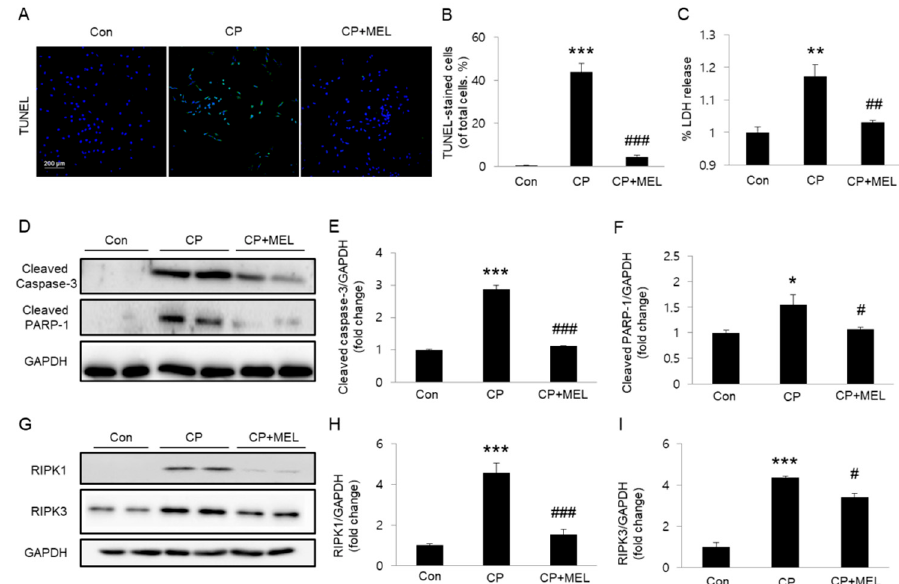
Figure 7. Effects of melatonin (MEL) on cisplatin (CP)-induced apoptosis and necroptosis in cultured TCMK-1 cells. TCMK-1 cells were pretreated with 1 mM MEL for 1 h and then treated with 2 μ g/mL CP for 24 h. ( A ) Representative images of TdT-mediated dUTP nick end labeling (TUNEL) staining. Scale bar: 200 μ m. ( B ) Number of TUNEL-positive cells. ( C ) lactate dehydrogenase (LDH) release assay. ( D ) Western blots of cleaved caspase-3 and cleaved poly(ADP-ribose) polymerase 1 (PARP-1) levels. ( E ) Quantification of cleaved caspase-3 level. ( F ) Quantification of cleaved PARP-1 level. ( G ) Western blots of receptor-interacting serine/threonine protein kinase 1 (RIPK1) and RIPK3 levels. ( H ) Quantification of RIPK1 level. ( I ) Quantification of RIPK3 level. * P < 0.05, ** P < 0.01, and *** P < 0.001 vs. Con. # P < 0.05, ## P < 0.01, and ### P < 0.001 vs. CP.